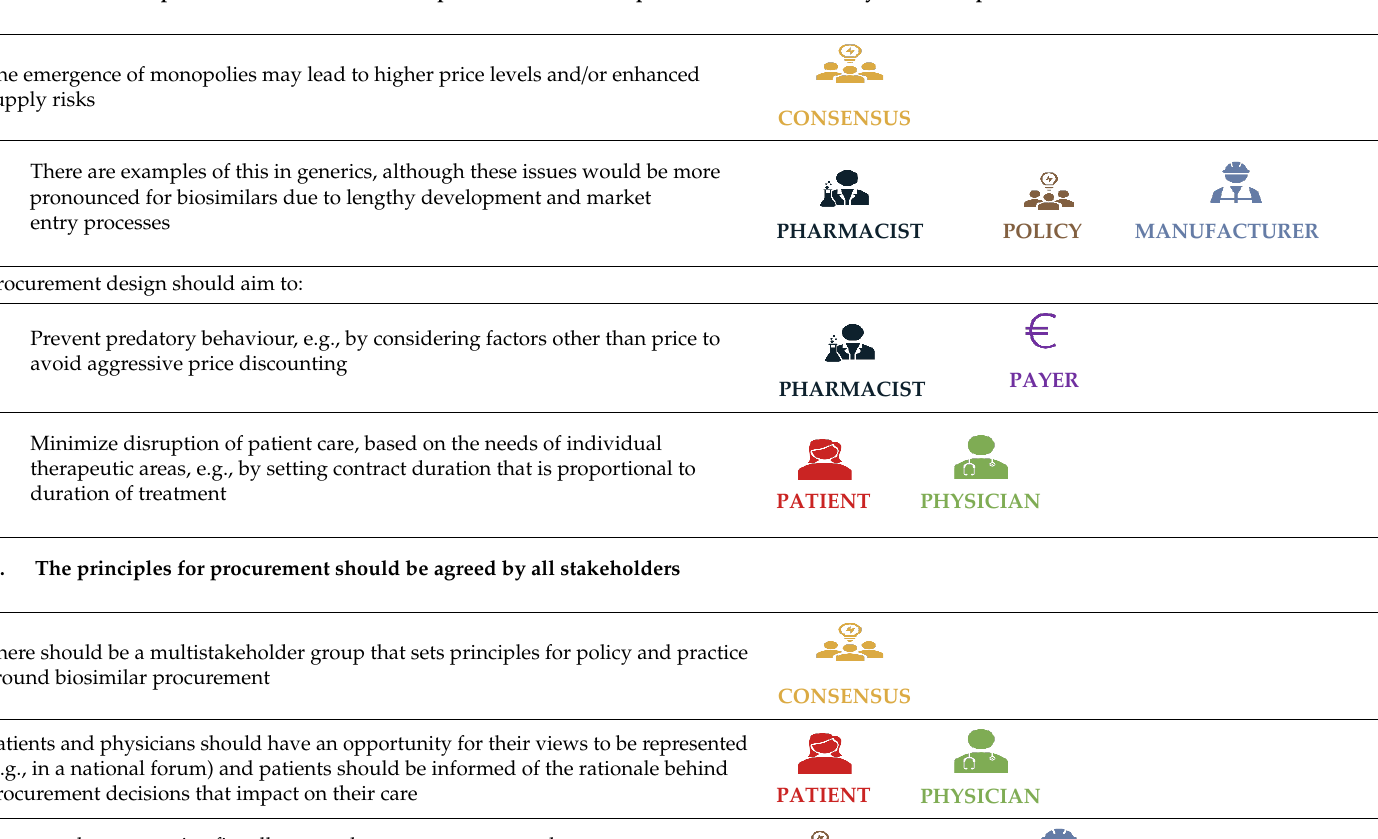
Table 3. Consensus on drivers and risks to biosimilar market sustainability (procurement processes).